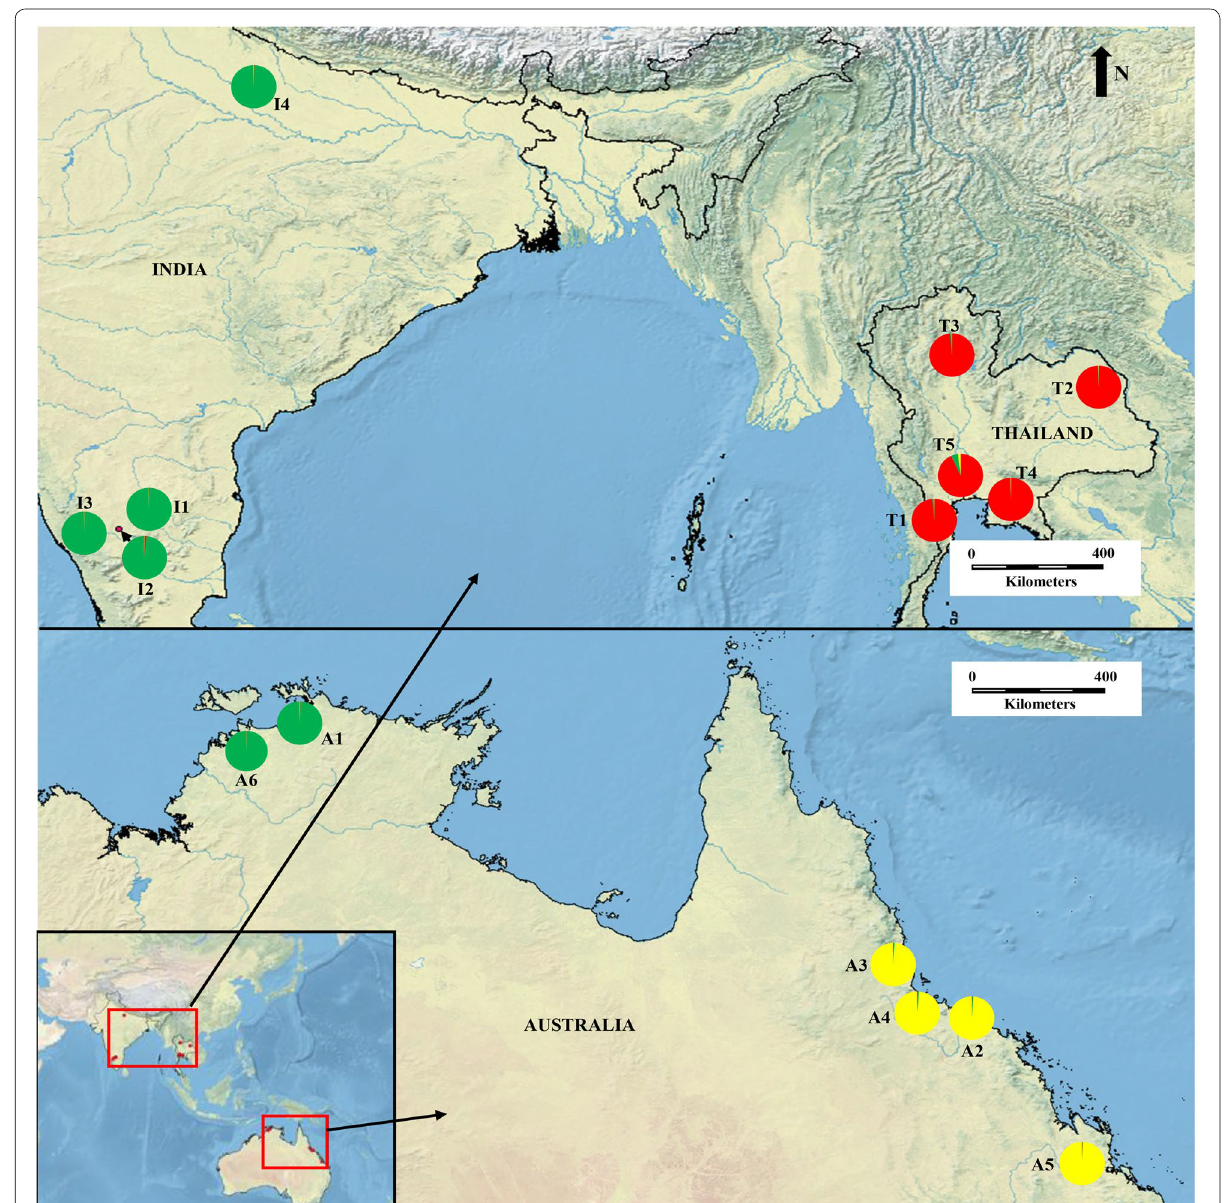
Fig. 1 Sample collection sites of 15 N. nucifera tropical populations in Australia, India, and Thailand. The pie charts indicate the proportion of admixtures in the three genetic groups (K 3), which were yielded by STRU CTU RE =